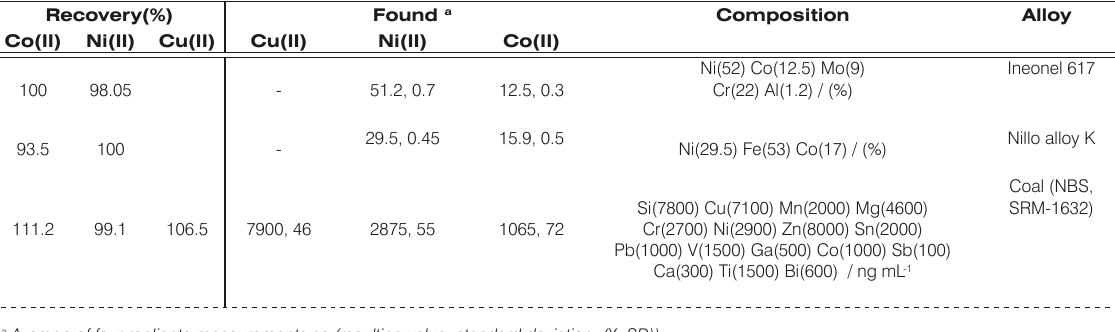
Table 5. Results of analysis of Co(II), Cu(II) and Ni(II) in alloys by the proposed